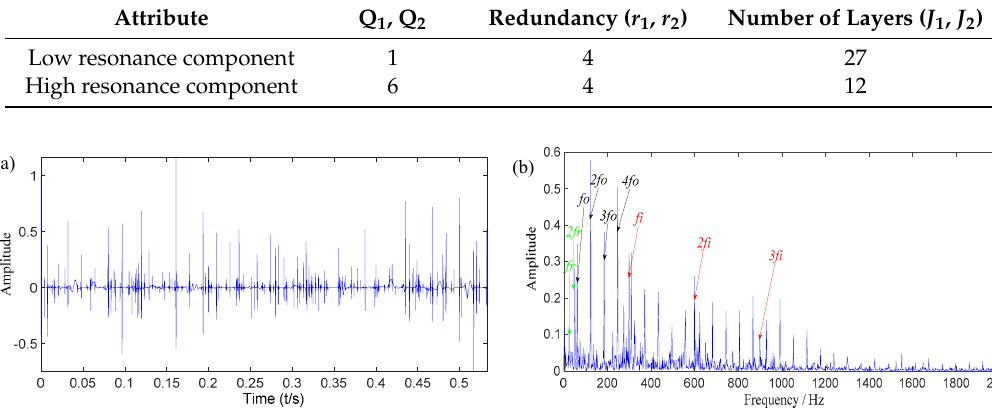
Table 3. The sparse decomposition parameters of case 1.